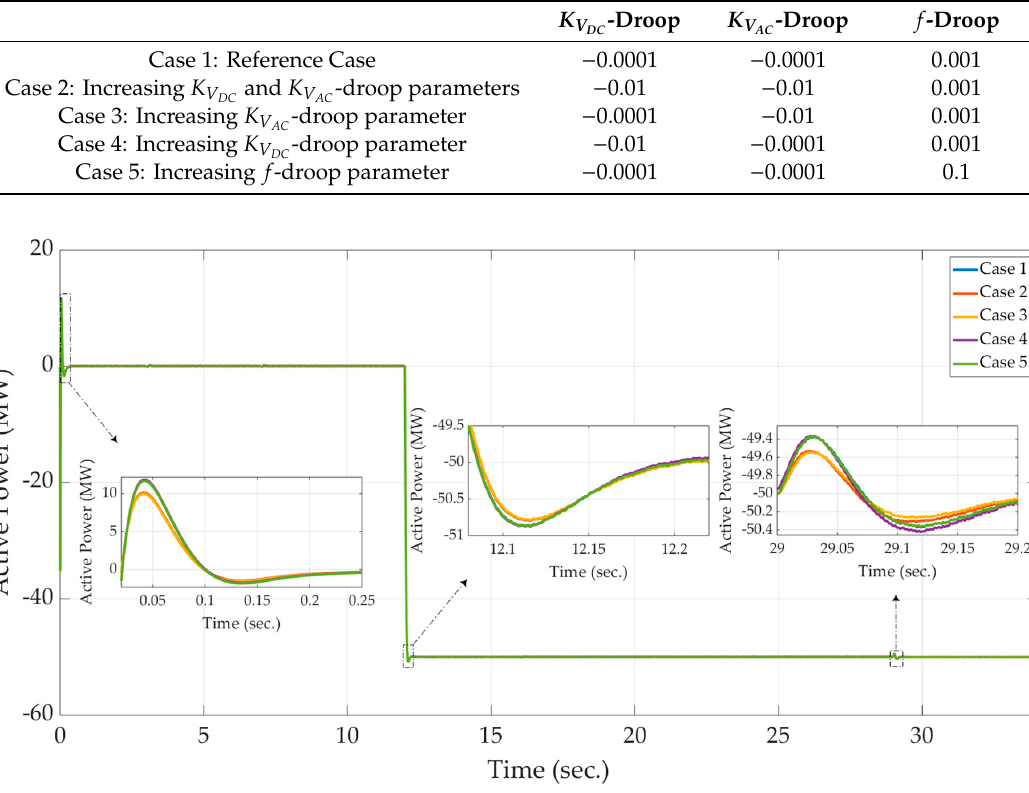
Figure 21. The impact of modifications of droop settings on the active power profile of VSC-HVDC station #4 in the third scenario.